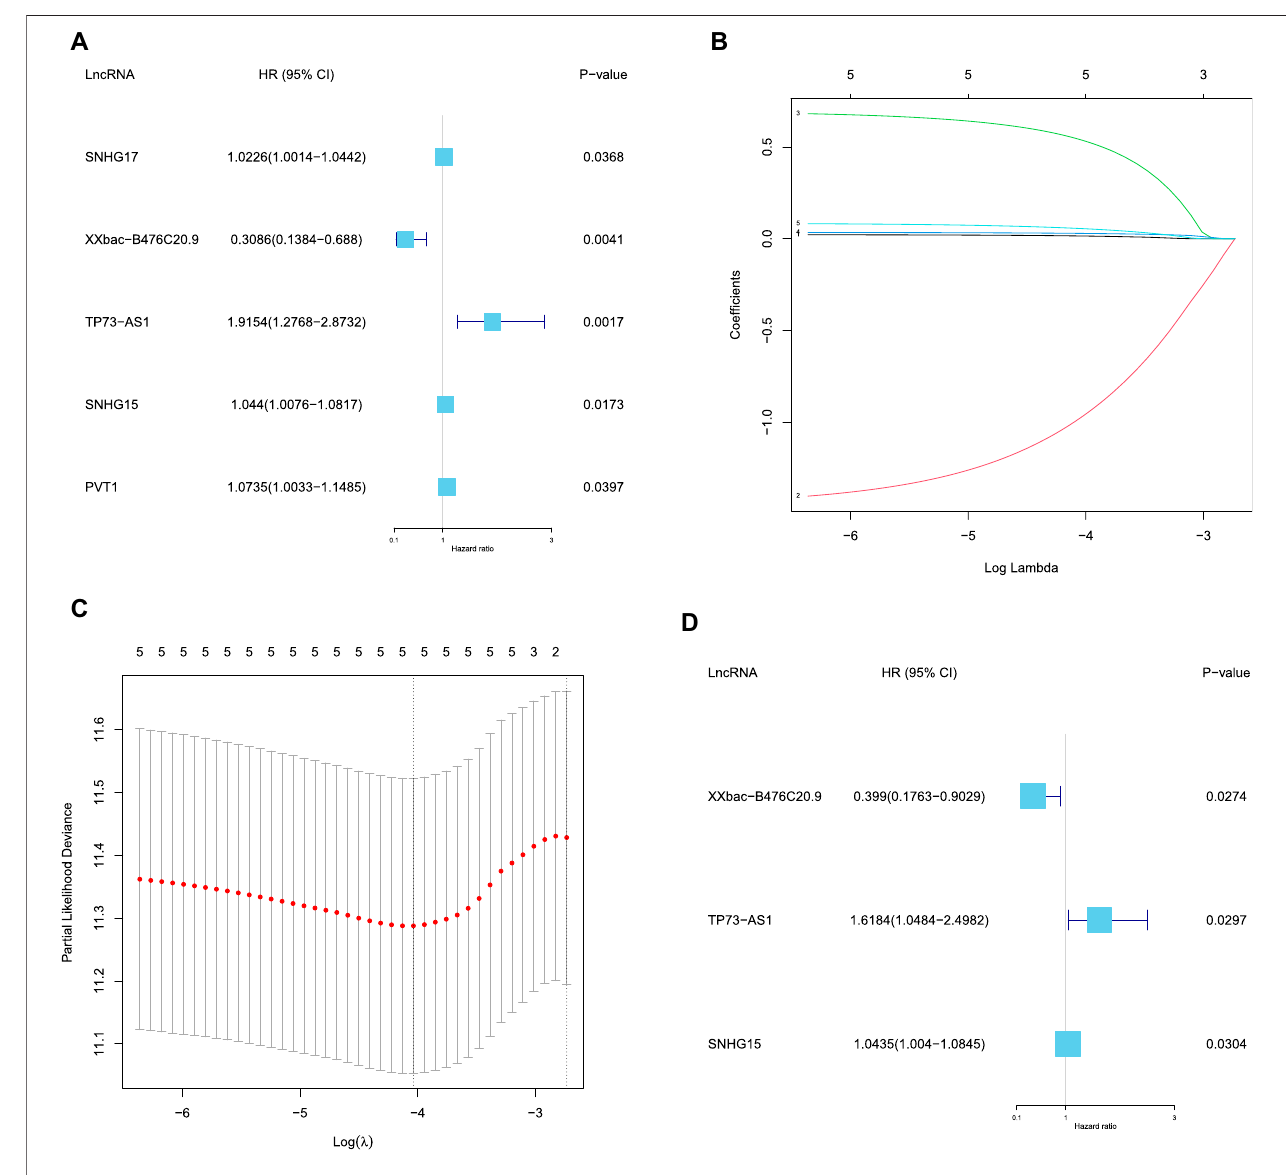
FIGURE 3 | Identi fi cation of the prognostic DEFR-lncRNAs. (A) Forest map of fi ve DEFR-lncRNAs identi fi ed by univariate Cox regression analysis. (B) LASSO coef fi cient pro fi le of the fi ve DEFR-lncRNAs. (C) Plots of the cross-validation error rates. (D) Forest map of three DEFR-lncRNAs identi fi ed by the multivariate Cox regression